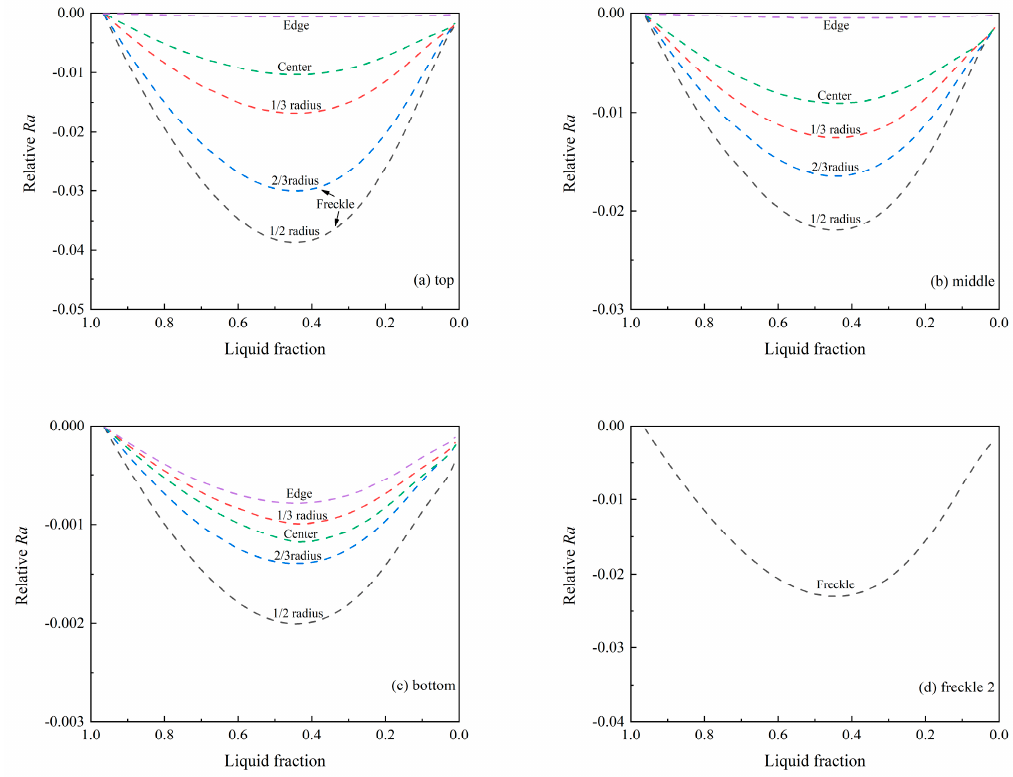
Figure 8. Relative Ra at different positions of the GCr15SiMn ESR ingot.